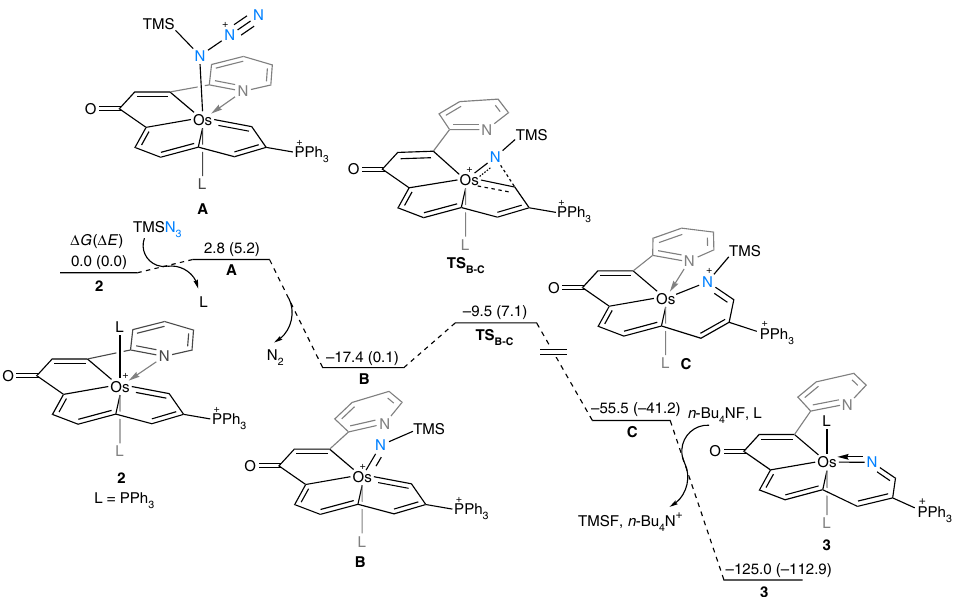
Fig. 4 Calculated energy pro fi le for the formation of structure 3 . The relative Gibbs free energies and electronic energies (within parentheses) are given in kcal mol −